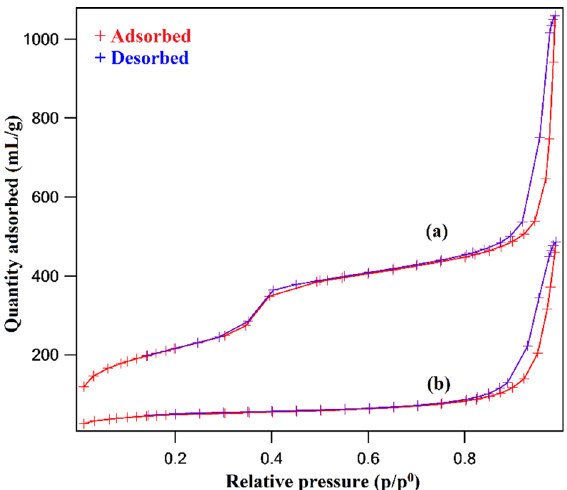
adsorption–desorption isotherms of: (a) MNPs@ Figure 8: N 2 MCM-41 and (b) MMNP.